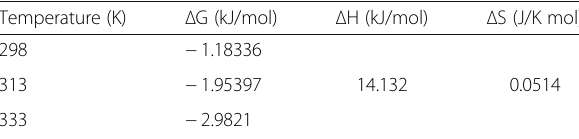
Table 3 Summary of Thermodynamic Parameter of AO67 onto RPSF